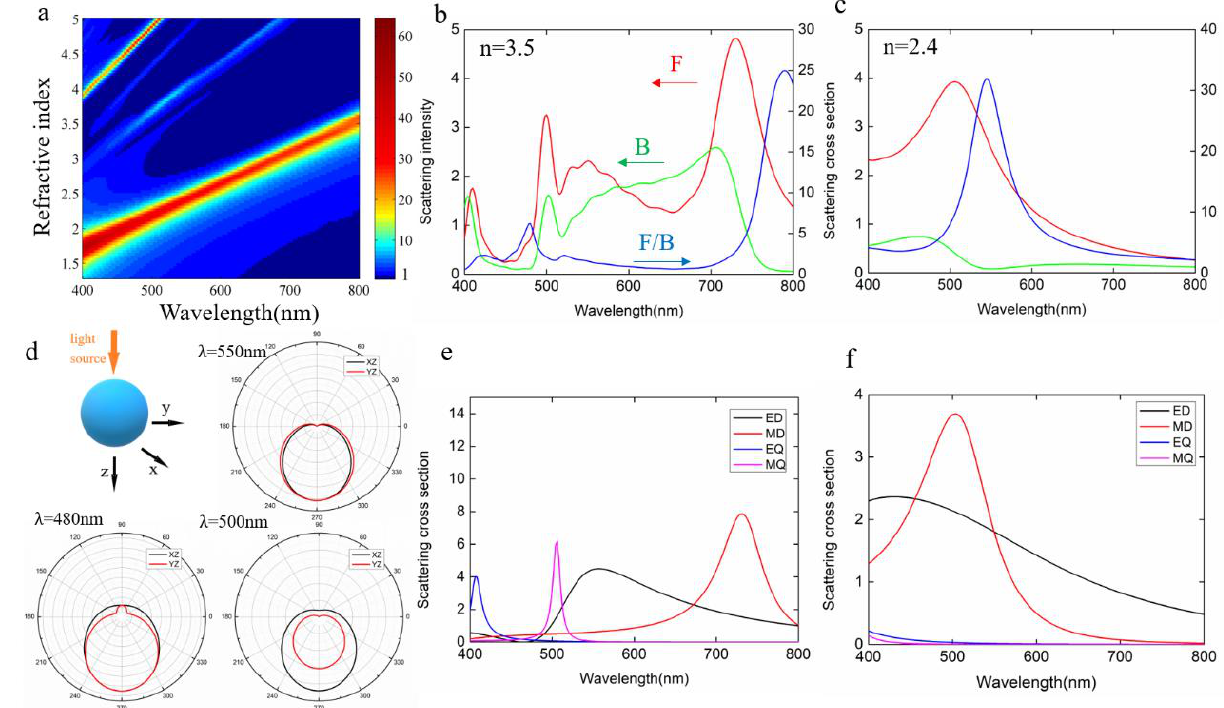
Figure 1. Effect of the refractive index on the forward/backward scattering. ( a ) The F/B value as a function of wavelength for spherical nanoparticles with a refractive index from 1.3 to 5. ( b ), ( c ) Forward and backward scattering and F/B spectra for spherical nanoparticles with a refractive index of 3.5 and 2.4. ( d ) Far-field scattering patterns of TiO 2 nanoparticles at the wavelengths of 480 nm, 500 nm and 550 nm. ( e ), ( f ) Multipolar decomposition by Mie scattering theory.